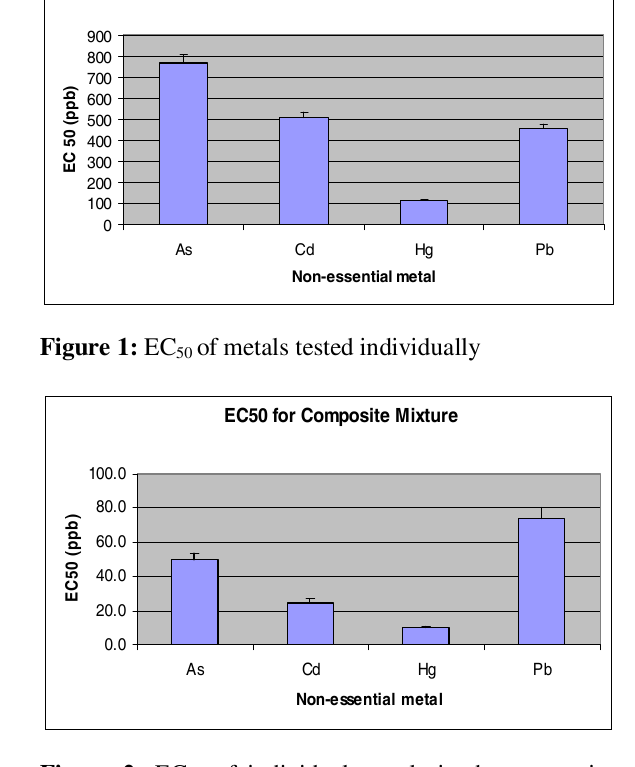
of individual metals in the composite